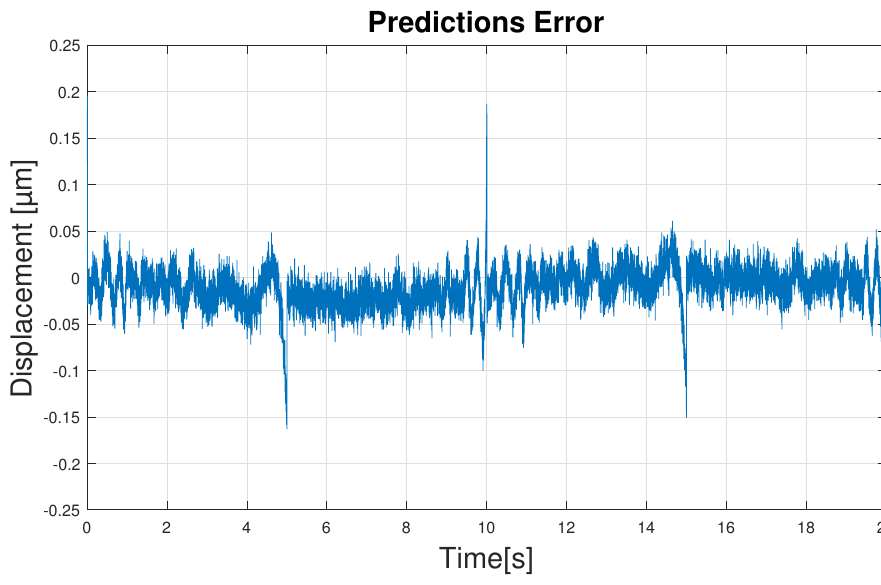
Figure 9. Neural Network predictions vs. real data.